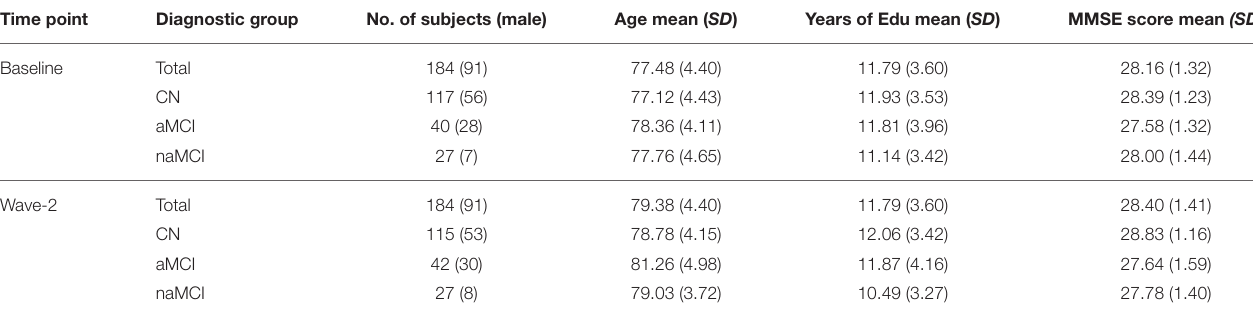
TABLE 1 | Demographic characteristics of the